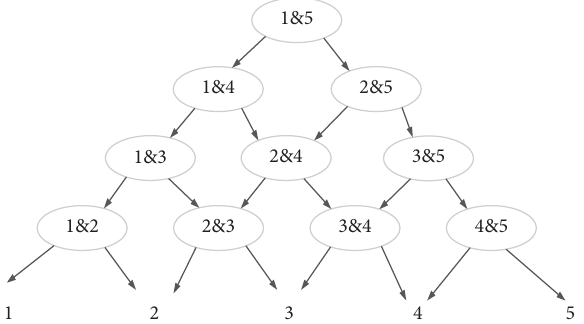
Figure 5: The architecture of 4-layer